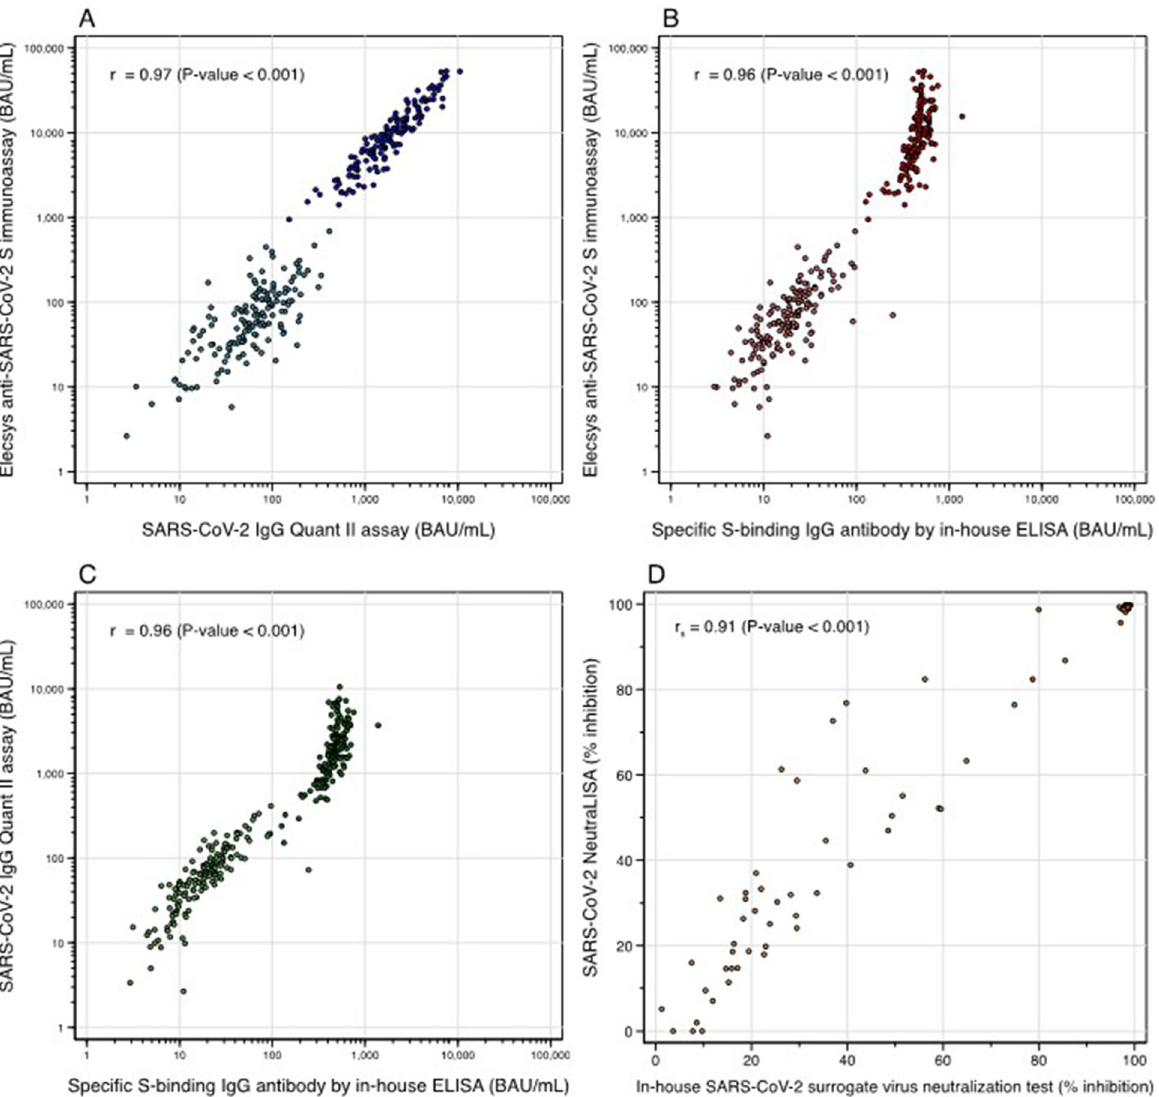
Figure 1. The correlations among binding-specific IgG antibody tests ( A , B , C ) and between in-house SARS- CoV-2 surrogate neutralization test and SARS-CoV-2 NeutraLISA ( D